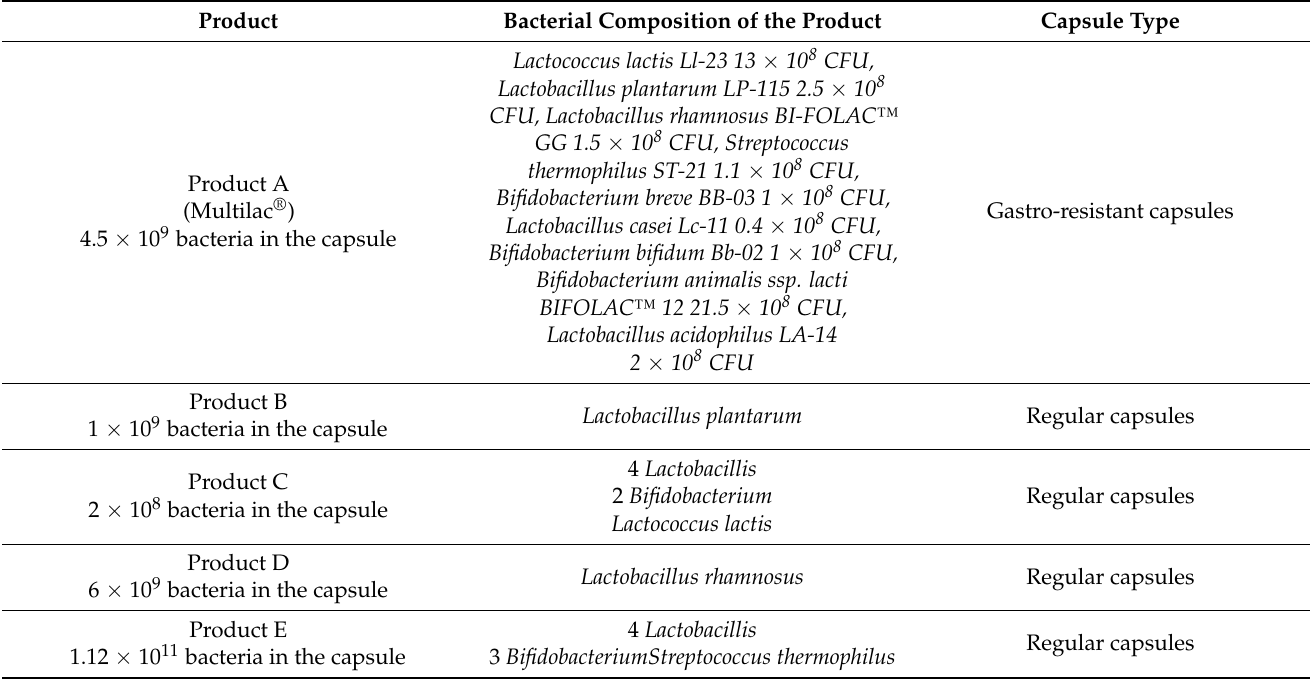
Table 1. Probiotic products used in the